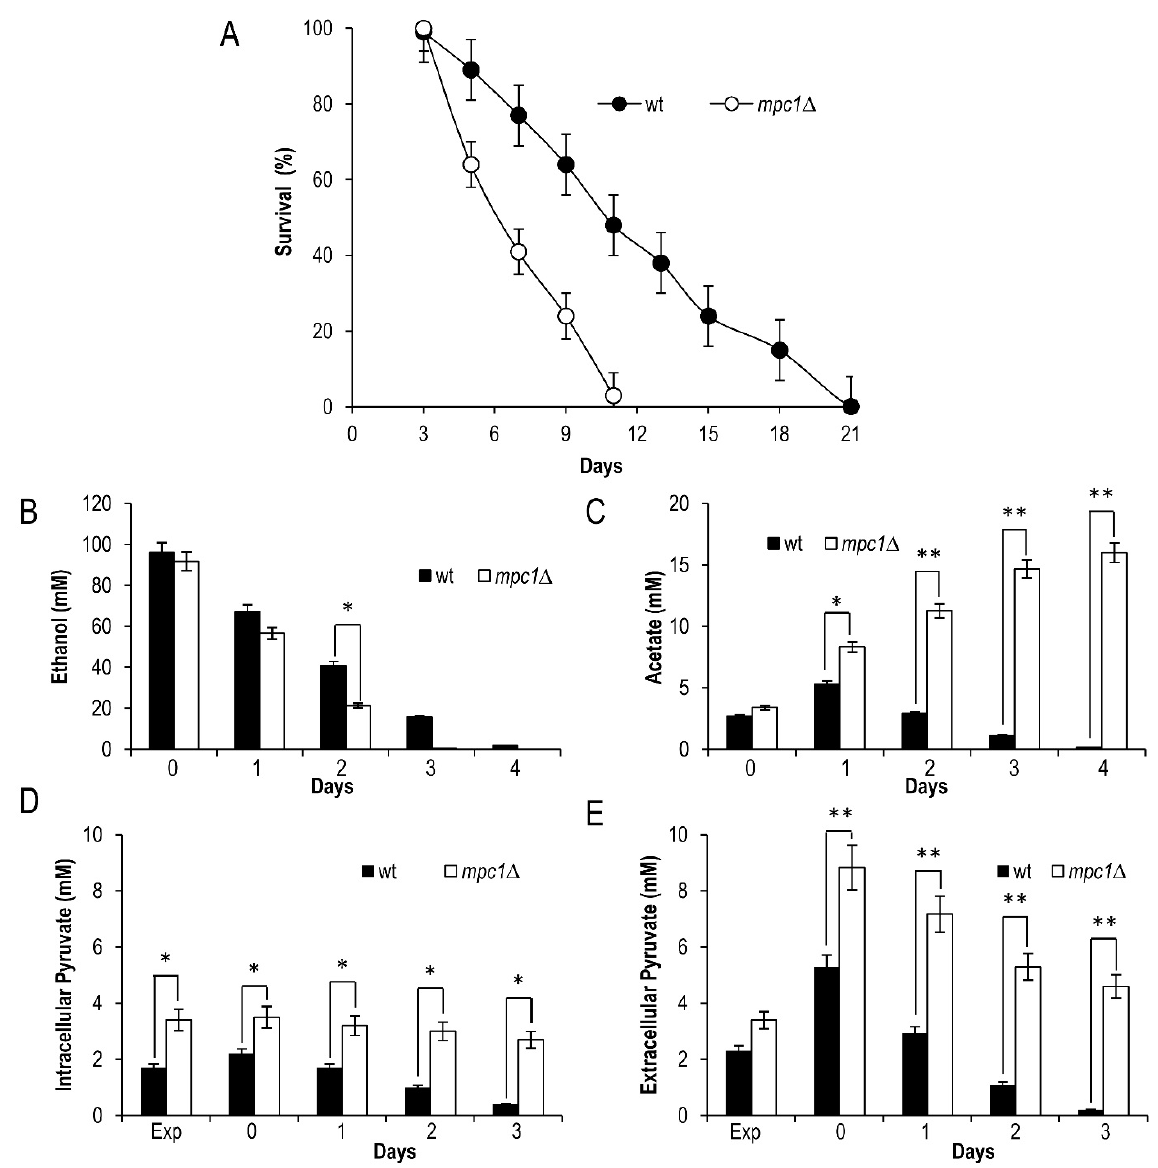
FIGURE 2: MPC1 inactivation shortens CLS in concert with increased extracellular acetate and pyruvate. Wild type (wt) and mpc1 Δ mutant cells were grown in minimal medium/2% glucose and the required supplements in excess (see Materials and Methods) and followed up to stationary phase. (A) CLS of wt and mpc1 Δ mutant cells. At each time-point, survival was determined by colony-forming capacity. 72 h after the diauxic shift (Day 3) was considered the first age-point (see Materials and Methods). Day 0, diauxic shift. Data refer to mean values of three independent experiments. Standard deviations (SD) are indicated. Bar charts of extracellular ethanol (B) and acetate (C) concentra- tions at different time points after the diauxic shift (Day 0). In parallel, intracellular (D) and extracellular (E) pyruvate concentrations were measured. Exp, exponential growth phase. Data refer to mean values of three independent experiments. SD is indicated. Statistical signifi- cance as assessed by one-way ANOVA test is indicated (* P ≤ 0.05 and ** P ≤